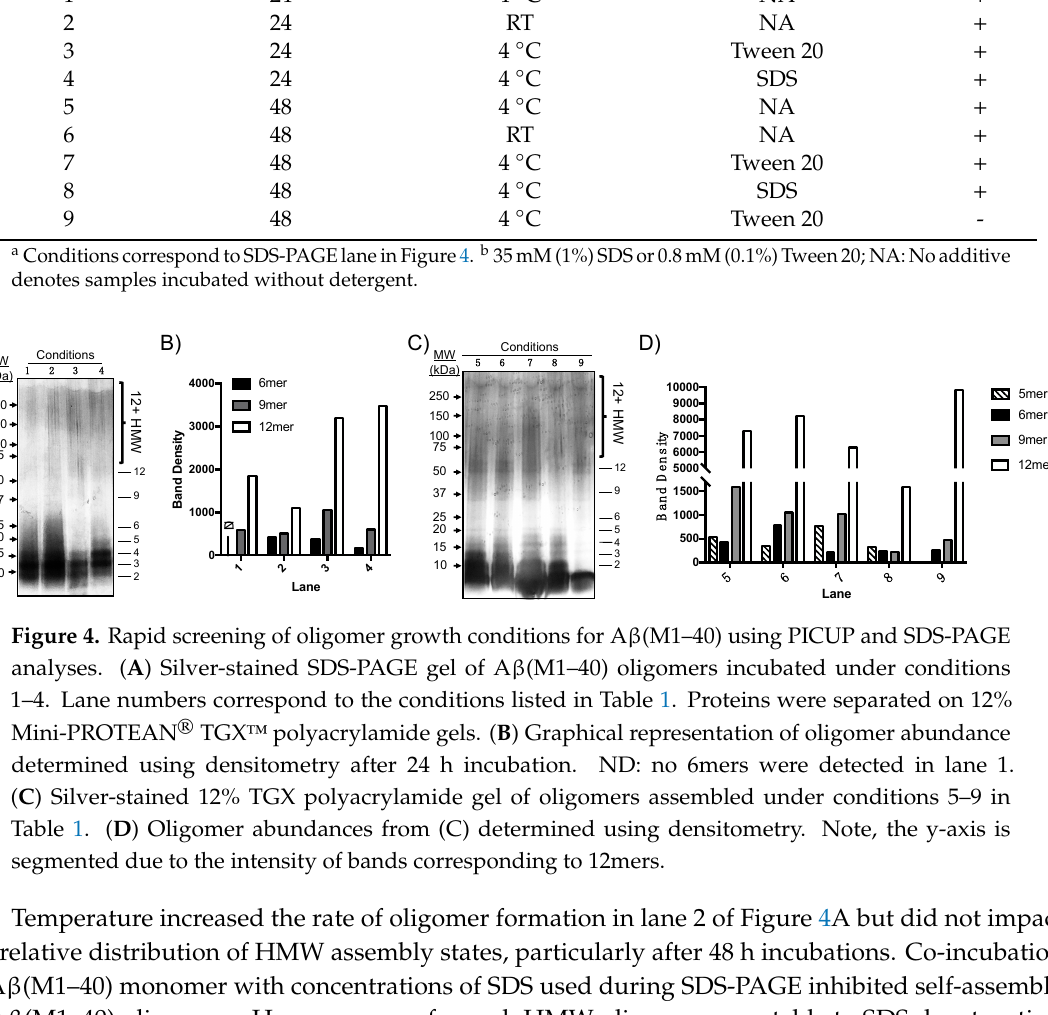
Table 1. ( D ) Oligomer abundances from (C) determined using densitometry. Note, the y-axis is segmented due to the intensity of bands corresponding to